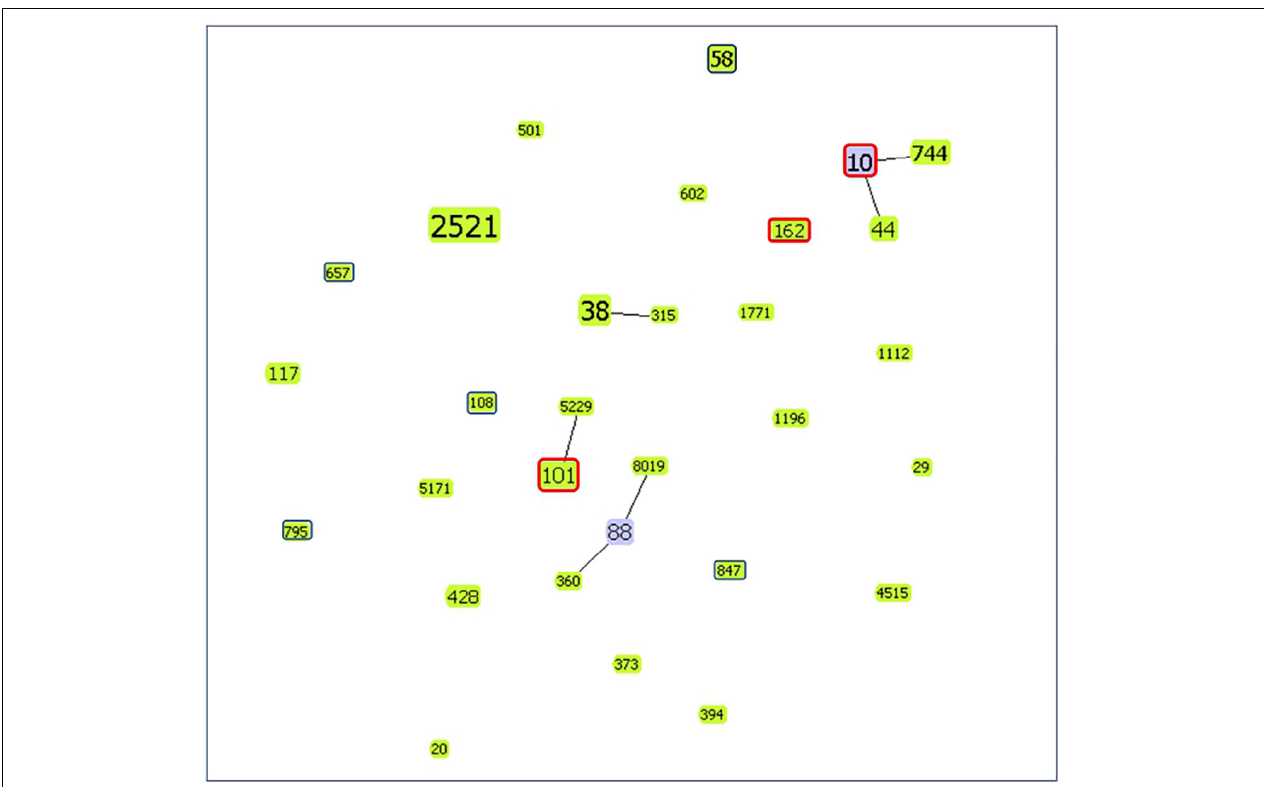
FIGURE 1 | goeBURST diagram showing the genetic relatedness of mcr-1 -positive E. coli isolates from the study and food animals reported in the literatures of Taiwan (Kuo et al., 2016; Liu J. Y. et al., 2020). The number within the node is the ST. Node size is based on the number of isolates with specific STs. ST of isolates in the study (from fecal samples of children) is marked with a dark blue frame. However, isolates with the same ST from the study and food animals of Taiwan reported in the literatures are marked with a red frame. Others without frame markings are ST of isolates from food animals in the literature of Taiwan. (Node color: light green: group founder; light blue: common